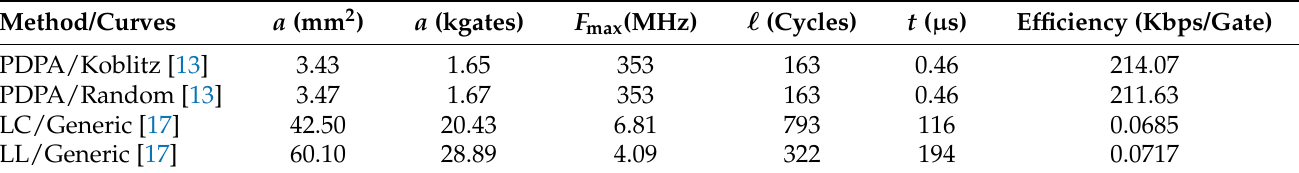
Table 12. Application-Specific Integrated Circuit (ASIC) (65 nm)-based implementation for F 2 163 .